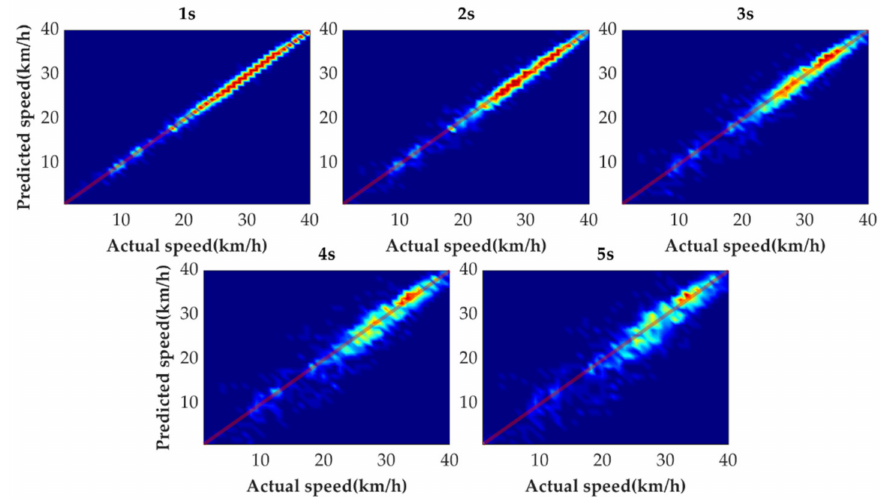
Figure 13. Heat map display of the predicted results of CNN.